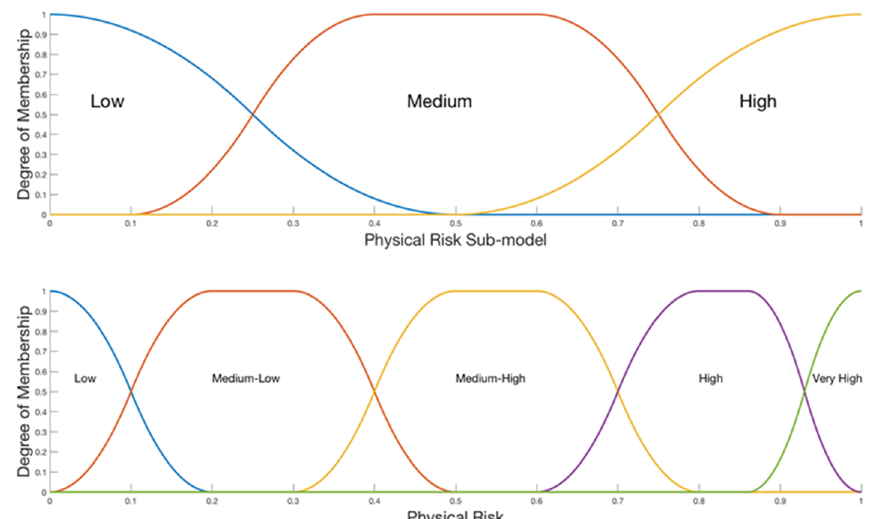
Figure 2. Simple conceptualization of the membership functions used for Physical Risk and Aggravation showing the input FIS (upper plot) and the output FIS (lower plot). The universe of discourse, and the exact parameters of the membership functions, are not shown in the figure since they depend on the variability and numerical range of each indicator’s numerical value.